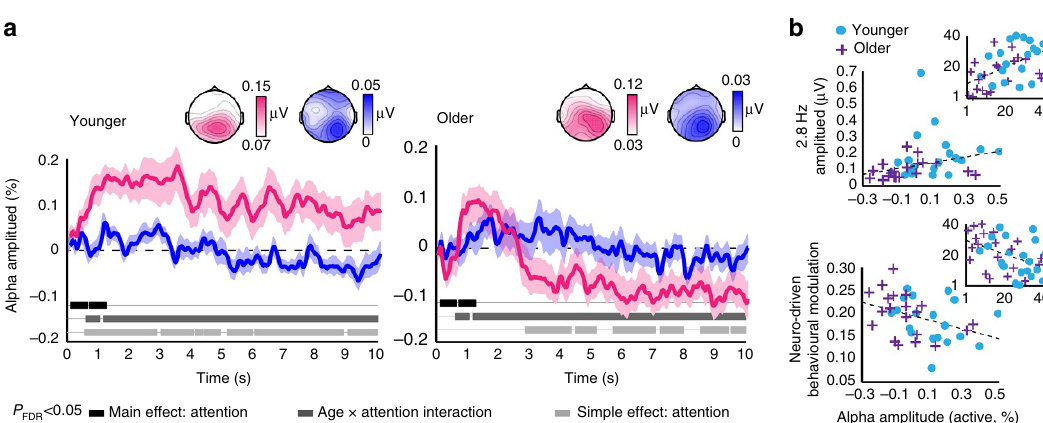
Figure 6 | Alpha amplitude dynamics differed between younger and older adults. ( a ) Younger adults showed a significant increase in alpha amplitude during active task performance compared to passive listening (left), while older adults (right) showed the opposite effect. FDR-corrected significance is shown for the main effects of attention (black) and age (cid:3) attention interaction (dark grey) on plots of both the younger and older alpha time courses. Simple effects of attention within each age group (light grey) are shown separately for younger and older data. Shaded regions show standard error of the mean. ( b ) Alpha amplitude averaged over the 10-s stimulus time course from electrode Pz correlated positively with 2.8Hz amplitude averaged over a fronto-central electrode cluster (Fz ,F3, F4, FC3, FC4, Cz, C3, C4; top) and negatively with neuro-driven behavioural modulation (bottom). Insets show ranks on which Spearman correlations were based. Ranks on alpha amplitude are plotted on the x axis. Y axis shows ranks on 2.8Hz amplitude (top) and on neuro-driven behavioural modulation